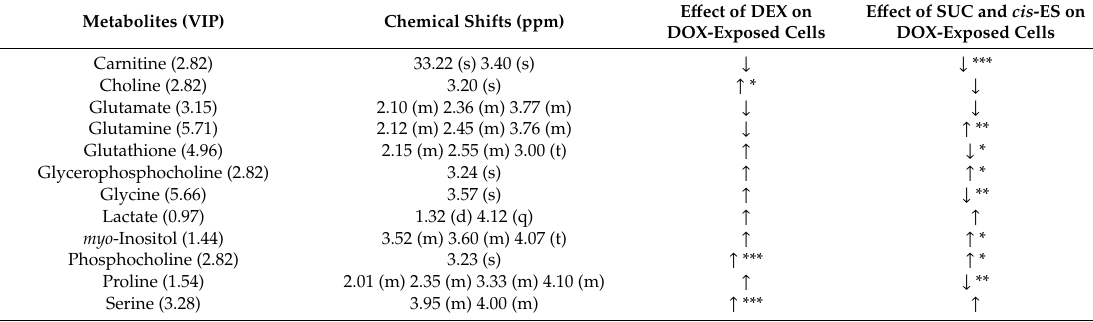
Figure 4. Projection to a latent structure discriminant analysis (PLS-DA) of the metabonomic data. ( A ) Scores plot of intracellular extracts after 24 h of exposure. R 2 cum = 0.58, Q 2 cum = 0.48, Hotelling’s T2 = 0.95 and p -value of ANOVA of the cross-validated residuals (CV-ANOVA) < 0.001. ( B ) Cross-validation plot of the intracellular extracts (R 2 in green and Q 2 in blue) with a permutation test repeated 200 times. The Y -axis intercepts were R 2 = (0.0; 0.12) and Q 2 = (0.0; − 0.32). ( C ) Scores plot of the extracellular compartments after 24 h of exposure. R 2 cum = 0.50, Q 2 cum = 0.41, Hotelling’s T2 = 0.95 and p -value (CV-ANOVA) < 0.001. ( D ) Cross-validation plot of the extracellular compartments (R 2 in green and Q 2 in blue) with a permutation test repeated 200 times. The Y -axis intercepts were R 2 = (0.0; 0.09) and Q 2 = (0.0; − 0.29). Table 1. Identified discriminant metabolites for the intracellular compartments, with the corresponding chemical